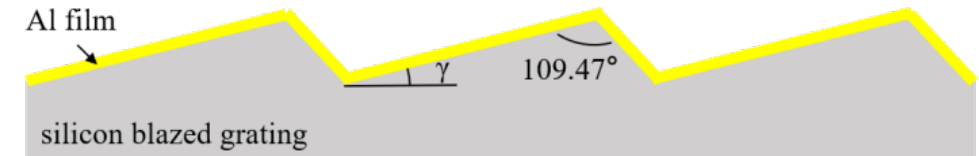
Figure 2. The grating model for diffraction efficiency simulation.